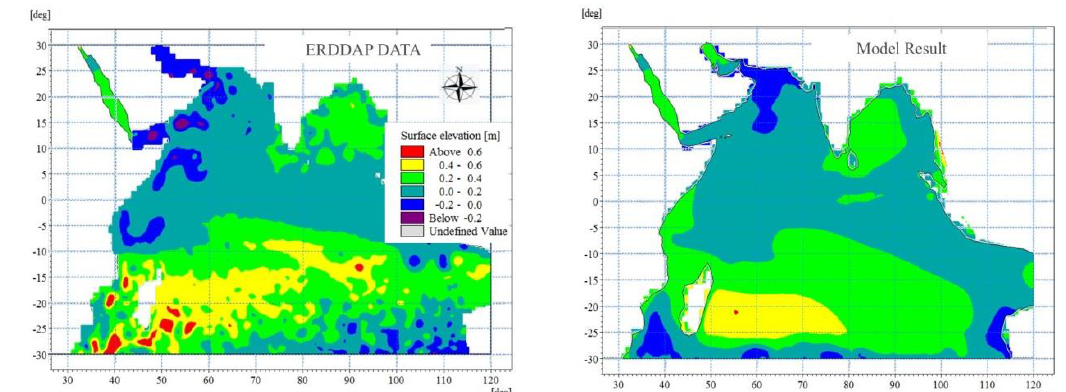
Figure 19. North Indian Ocean SSH; ERDDAP data (left panel) and model results (right panel) Great Whirl (GW) which appears in Figure 18, an eddy which transports the water from Somali coasts towards east (offshore) reaches to its most developed stage in August. This causes coastal upwelling and appears as an abrupt drop in Sea Surface Temperature (SST) at its location. Figure 20 illustrates a comparison between Modis Satellite data analyzed by Savtchenko [19] and model results. Dashed circles locate the decreased SST caused by GW.